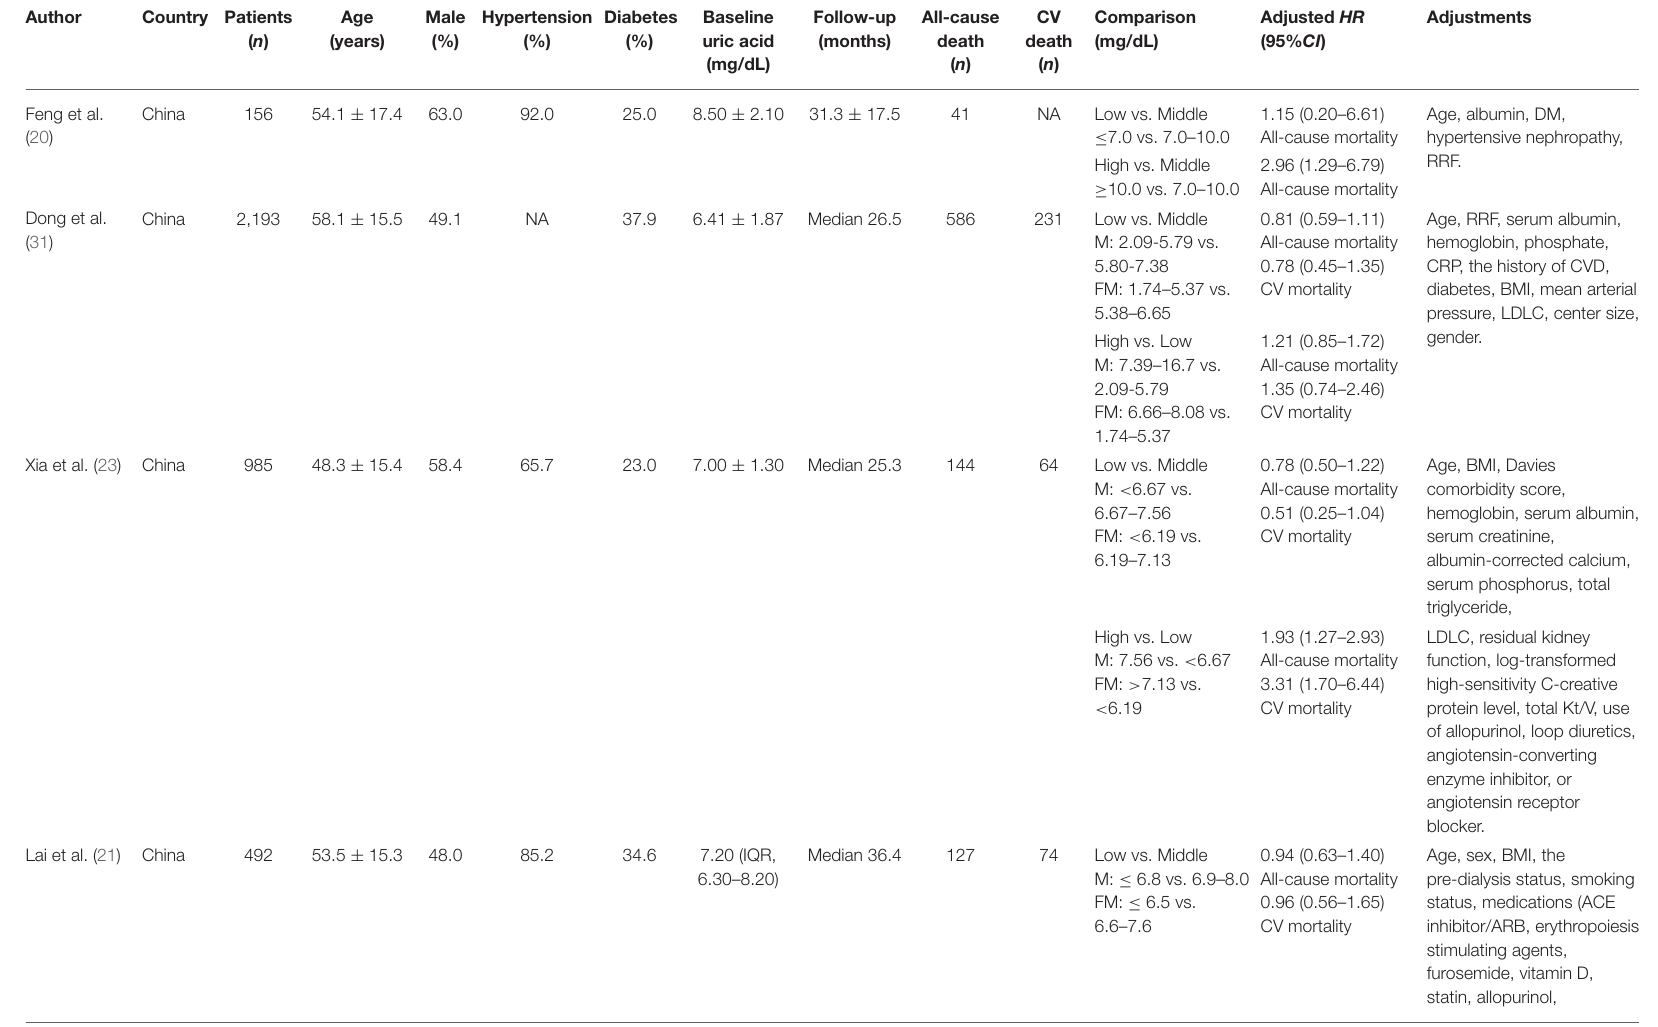
TABLE 1 | Characteristics of 7 studies included in the